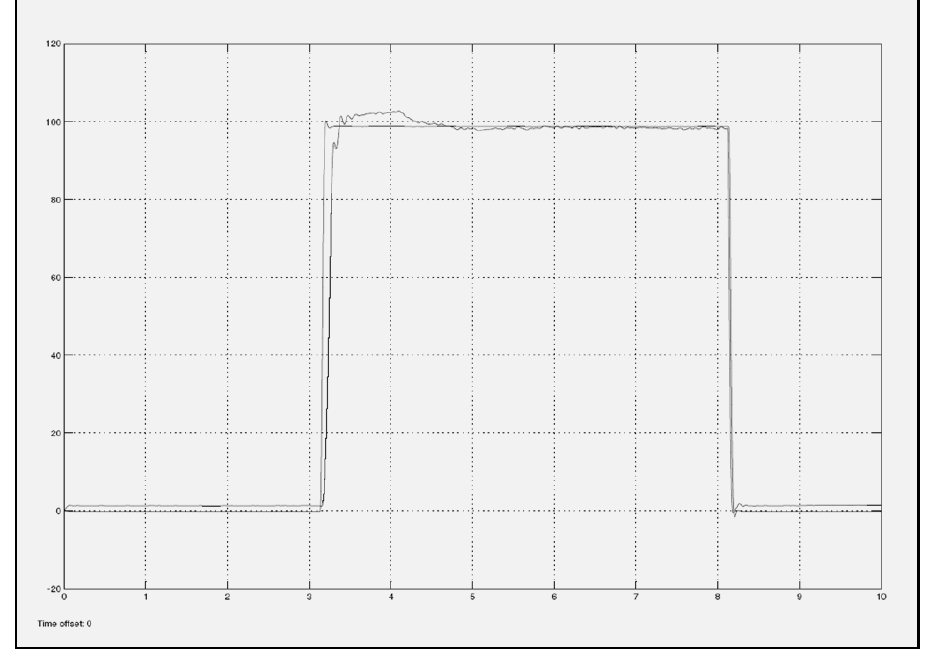
Figure 7. Good EFC Valve with 1.6 Amps current input.